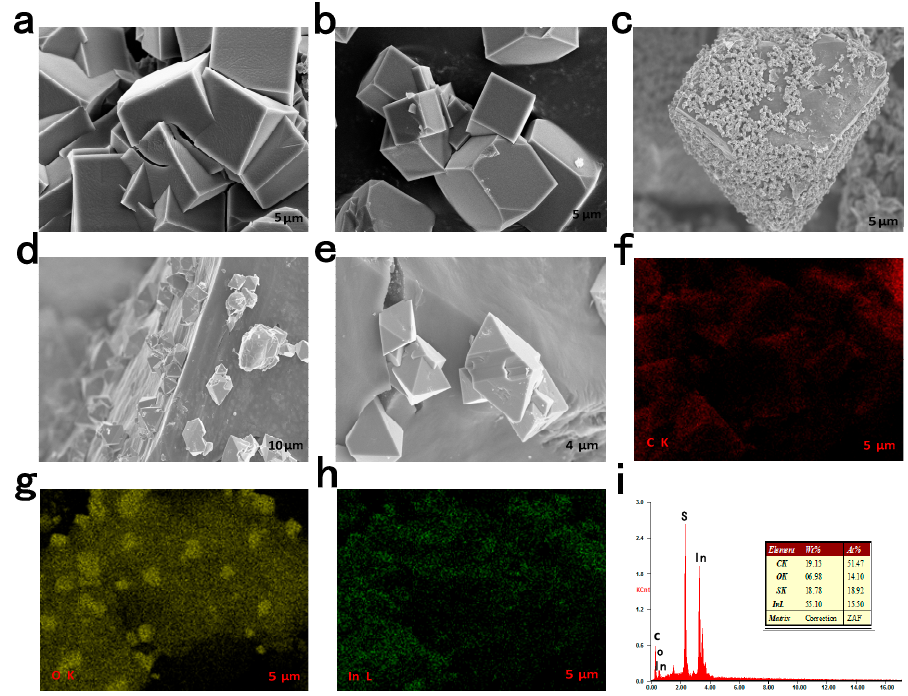
Figure 2. SEM images of: ( a , b ) CPM-5 and ( c – e ) CPM-5-C-600. ( f – h ) The elemental mapping of Indium oxide particles of CPM-5-C-600. ( i ) The corresponding EDX of CPM-5-C-600@S.